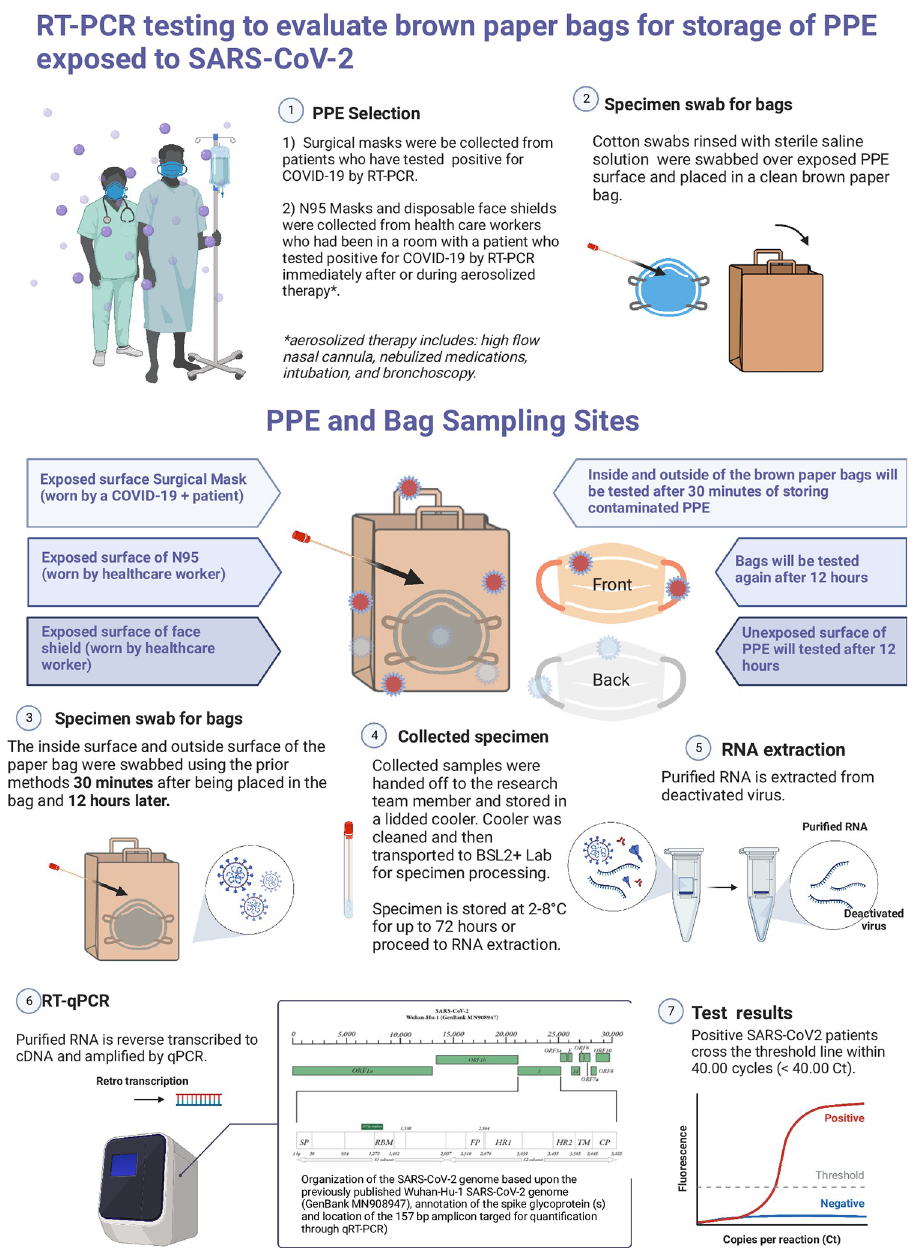
Fig 1. Protocol Infographic “Created with